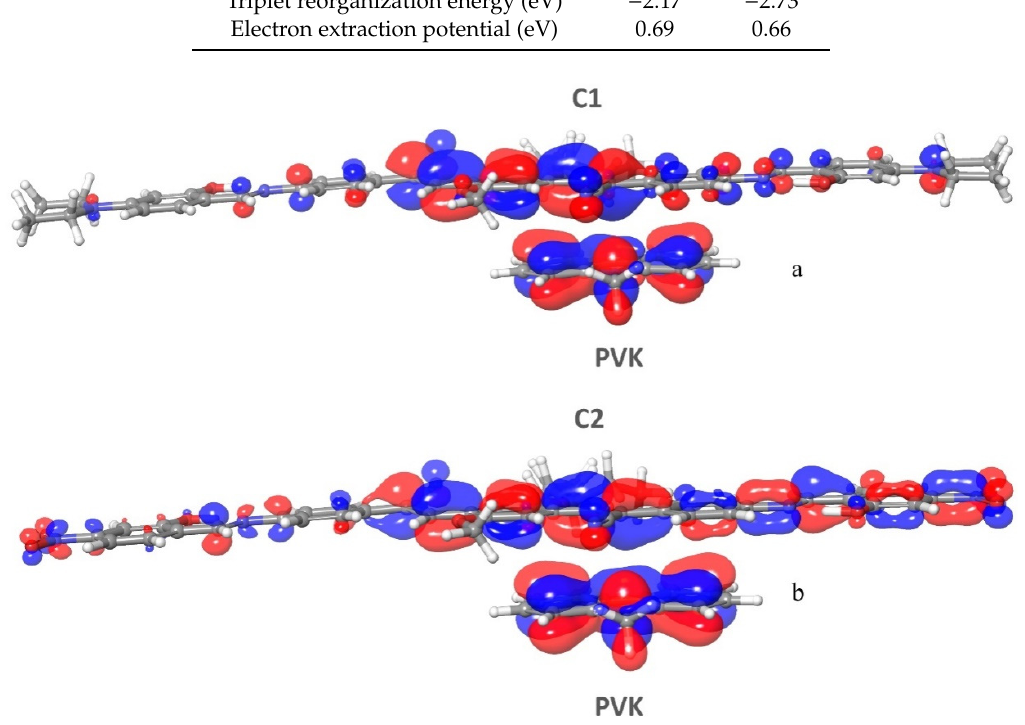
Figure 2. Frontier orbital representation for systems C1 ( a ) and C2 ( b ).